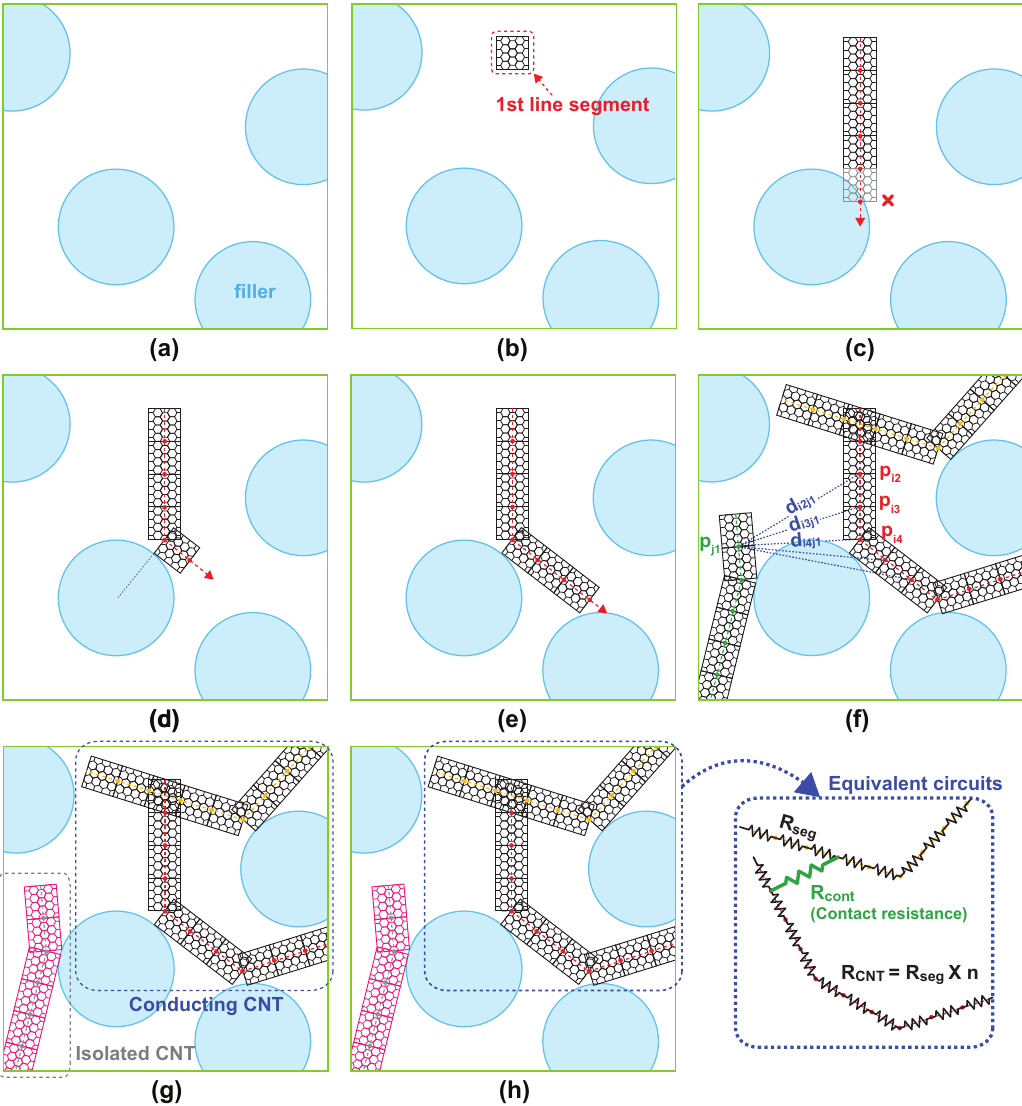
Figure 1. Generation of an instance of CNT/silica composite in Monte Carlo simulation: ( a ) placement of particulate fillers, ( b – e ) creation of a single bending conducting filler, ( f ) examination of the connection status of NWs, ( g ) clustering analysis of the NW network, and ( h ) equivalent circuits of the NW network for KCL